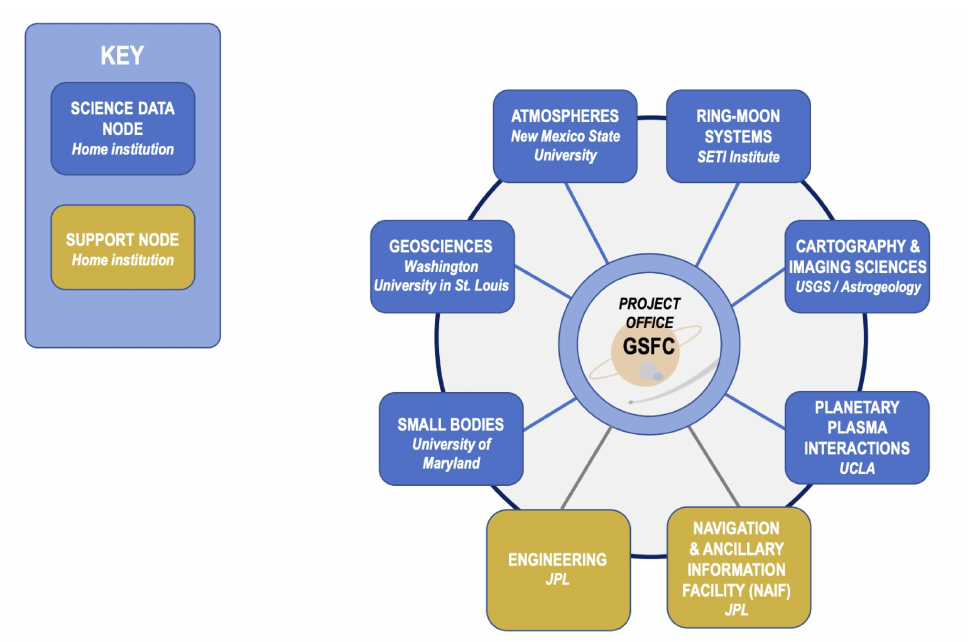
Figure 1. Organizational structure of the PDS. The Discipline Nodes are shown in blue boxes. The support nodes, shown in gold boxes, contain experts in areas that cover numerous missions. The Radio Science Subnode, currently at RMS, supports data providers and users with the specialized needs of radio science